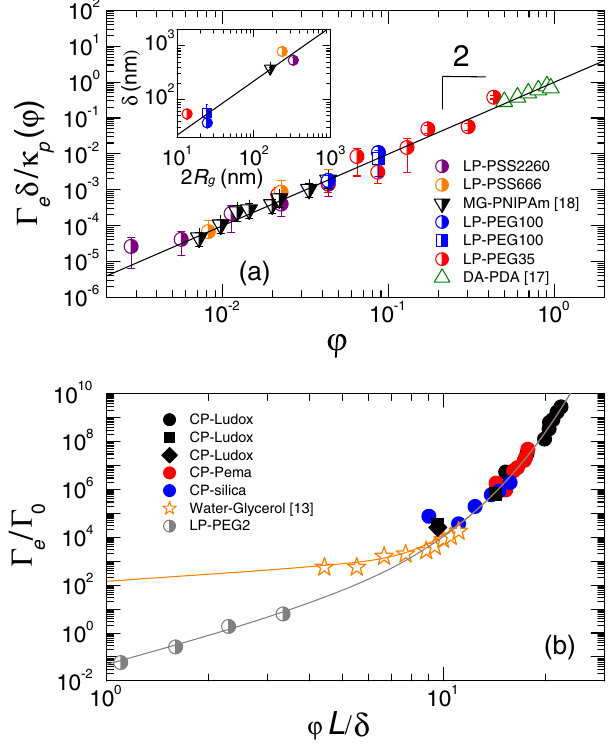
FIG. 2. Nonequilibriuminterfacetension(samedataasinFig.1), plotted using the reduced variables suggested by Eqs. (10), (11), and (13). (a) Data for all polymer systems except LP-PEG2. The δ = κ ð φ Þ ¼ φ 2 predicted by the theory. Inset: line is the law Γ e p Interface thickness obtained from the fits as a function of the polymer size. The line is the linear law δ ¼ 4 . 4 R . (b) Normalized g interfacial tension for colloidal suspensions, short polymers (LP-PEG2), and water-glycerol mixtures. The lines are fits of Eq. (10), with Γ SG ¼ 0 for CP suspensions and Γ SG as in Eqs. (11) and (13) for LP-PEG2 and water-glycerol mixtures,